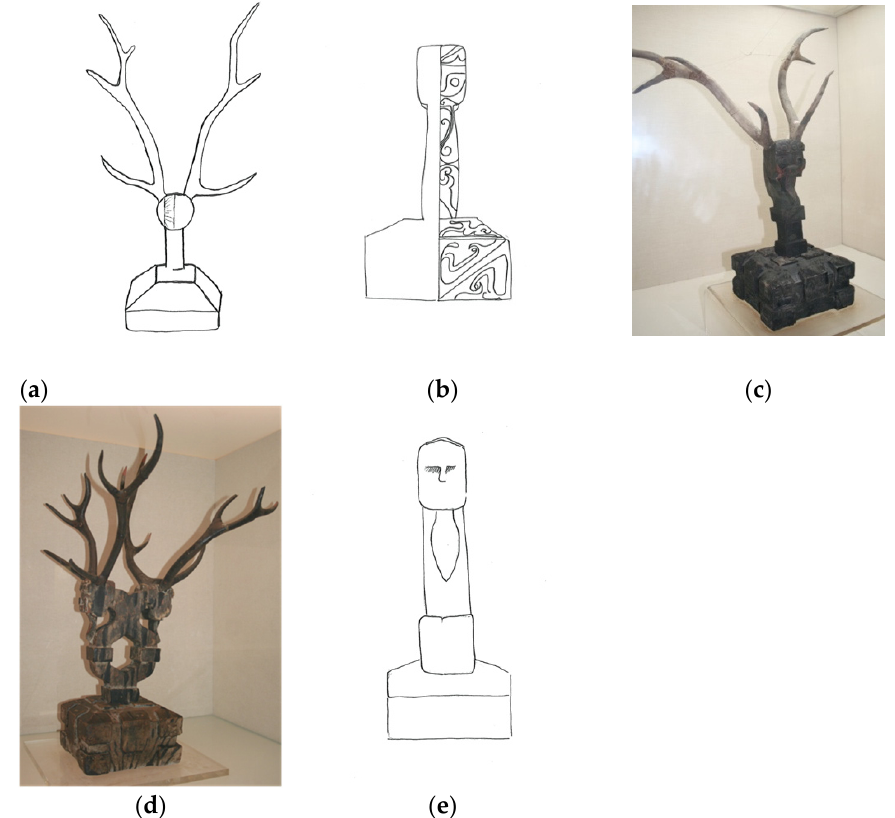
Figure 2. Five typologies of lacquered wood antlered sculptures excavated in Jiangling County, Hubei. ( a ) Line drawing of antler stand excavated from Tomb 142 at Yutaishan. Adapted from Hubei sheng Jingzhou diqu bowuguan (1982, plate 67.1) courtesy of Zay Olsen. ( b ) Line drawing of antlered tomb sculpture with painted features excavated from Tomb 516 at Yutaishan. Antlers are not shown. Adapted from Hubei sheng Jingzhou diqu bowuguan (1982, plate 67.2) courtesy of Zay Olsen. ( c ) Single-headed antlered and tongued sculpture with carved features (mature Hanxi style) in the Jingzhou Museum. Photo by author. ( d ) Addorsed antlered and tongued sculpture with carved features in the Jingzhou Museum. Photo by author. ( e ) Line drawing of anthropomorphic antlered and tongued sculpture. Antlers are not shown. Adapted from Hubei sheng Jingzhou diqu bowuguan (1982, plate 68.3) courtesy of Zay Olsen.